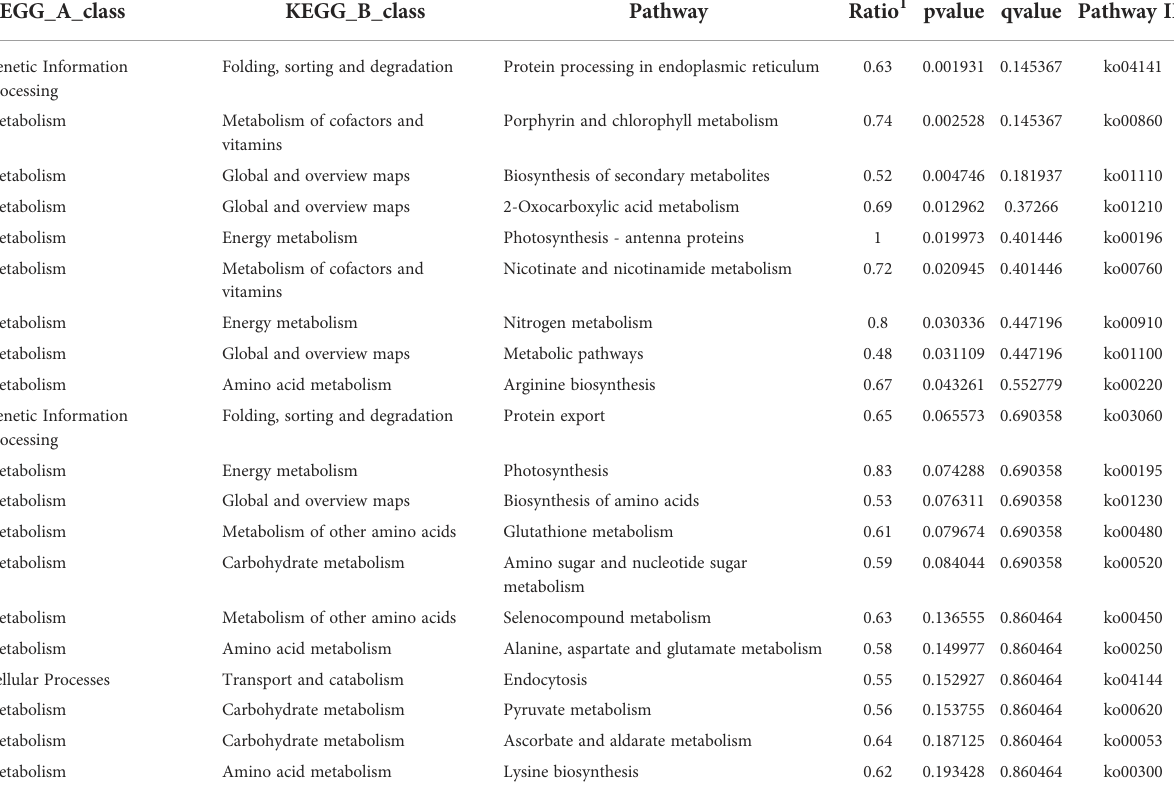
TABLE 3 Top 20 Kyoto Encyclopedia of Genes and Genomes (KEGG) pathways enriched by differentially expressed genes (DEGs) of EC vs NEC.